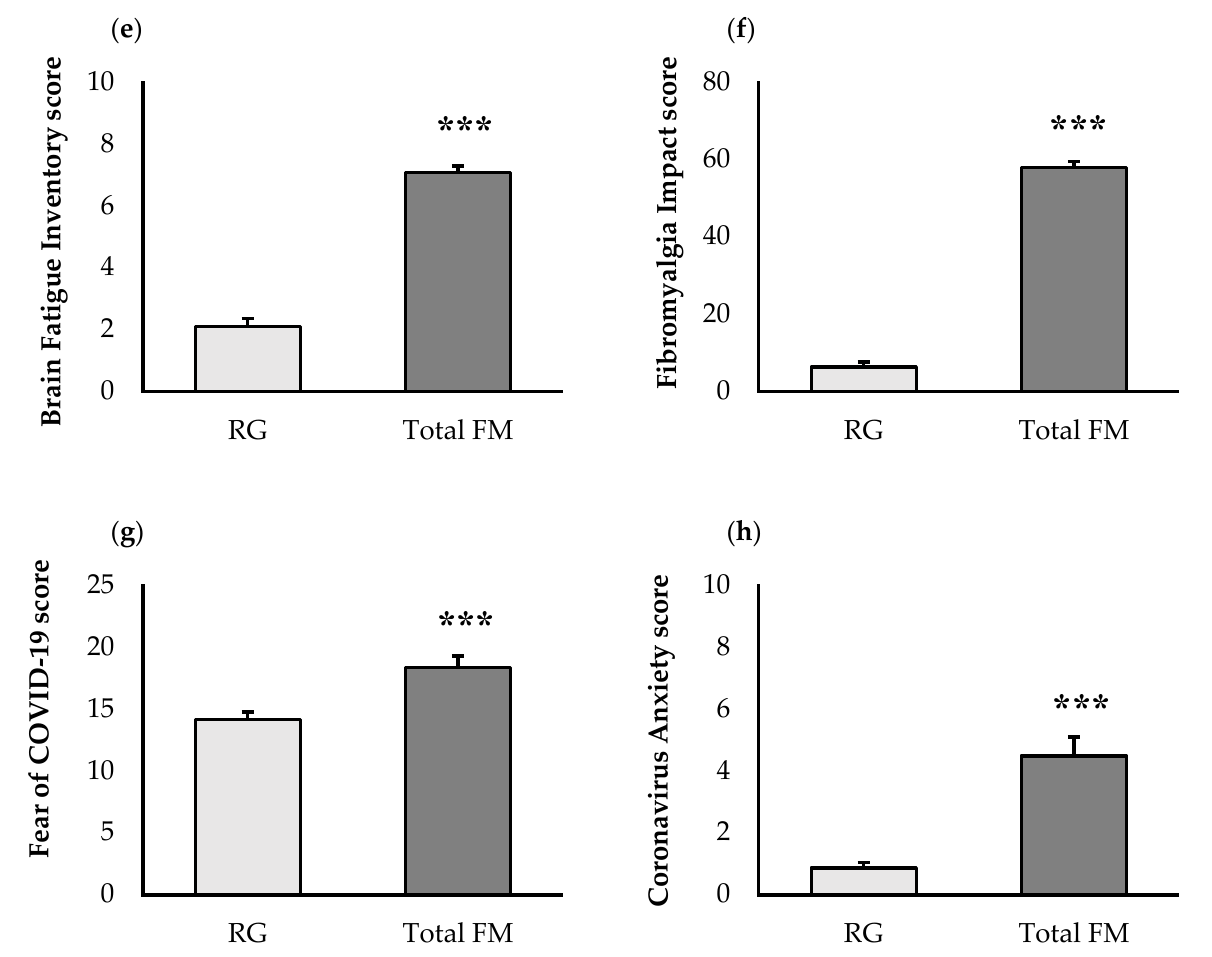
Figure 2. Psychological state and quality of life of FM patients (Total FM, n = 70) compared to an age-matched reference group of “healthy” women (RG, n = 70): perceived levels of ( a ) depression; ( b ) stress; ( c ) anxiety; ( d ) pain; ( e ) fatigue; ( f ) fibromyalgia impact; ( g ) fear of COVID-19; ( h ) coro- navirus anxiety. Determinations are expressed by the mean ± SEM of each group. RG: Reference Group, FM: Fibromyalgia. *** p < 0.001 with respect to the reference group.